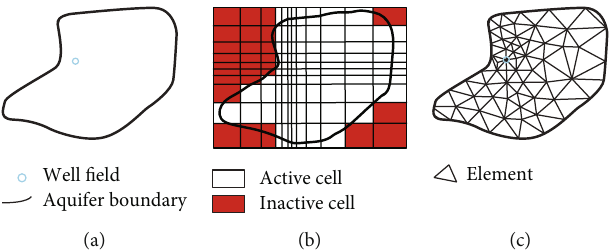
Figure 2: Hypothetical application of fi nite di ff erence (b) and fi nite element (c) grids to an irregularly bounded aquifer (a) (adopted and modi fi ed from Konikow and Reilly